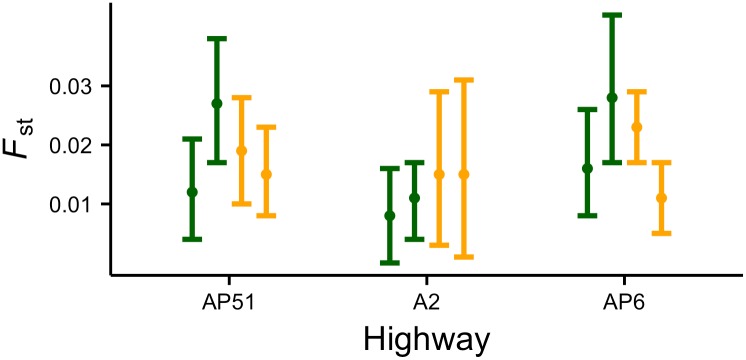
Comparison of genetic patterns for the three highways obtained from FST.Green and orange lines represent the genetic differentiation observed between, respectively, sampling lines on opposite roadsides and on the same roadside. Dots represent mean values and limits are 95% confidence intervals.